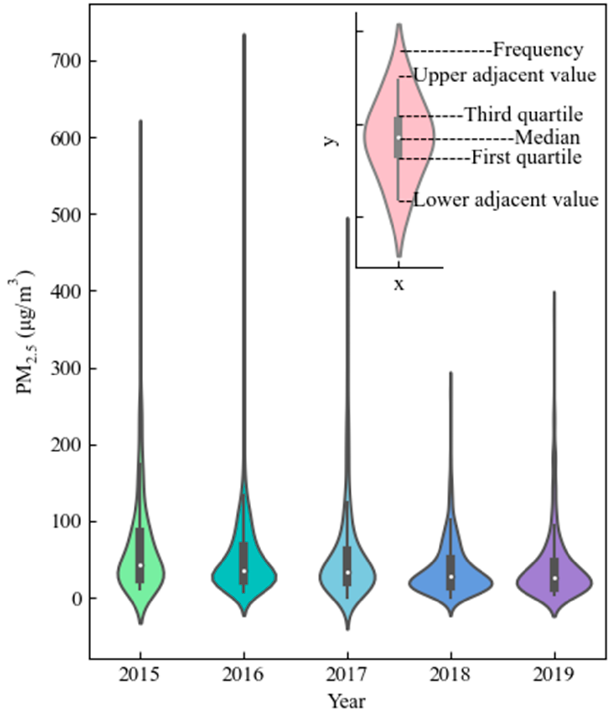
Figure 6. Distribution of PM 2.5 by